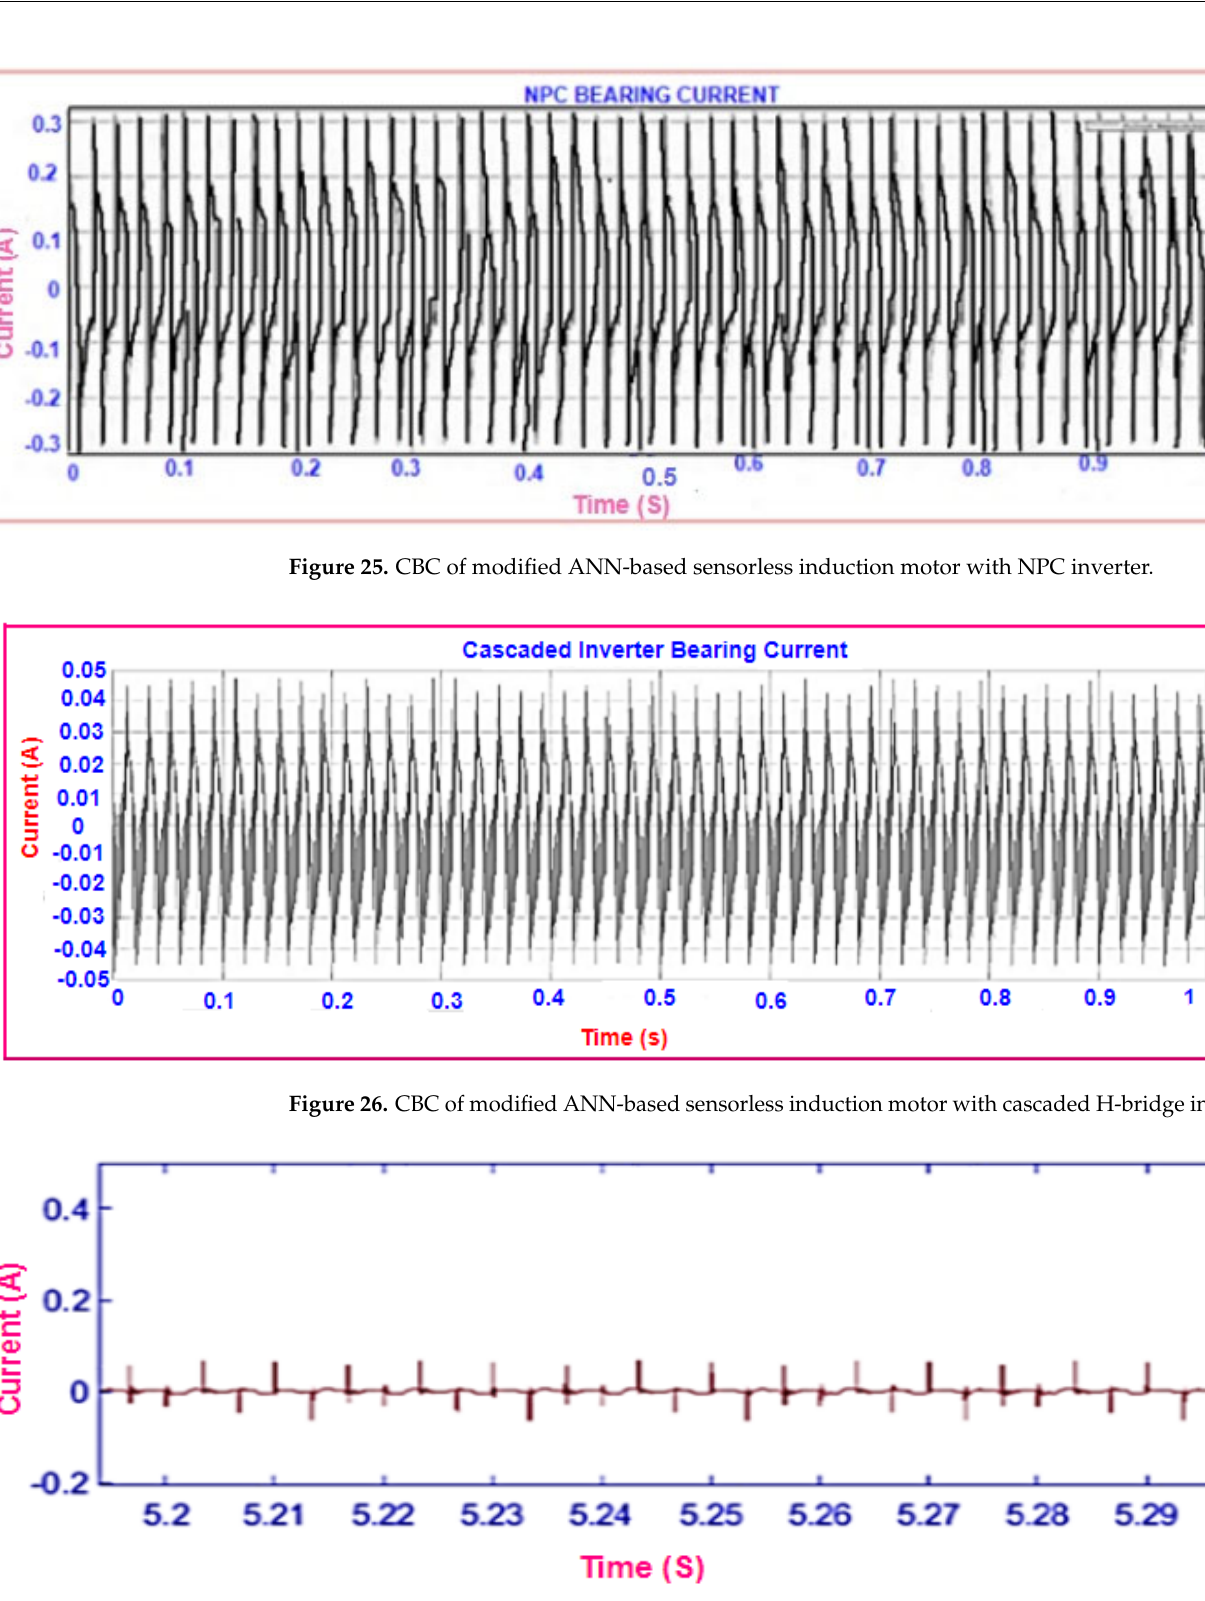
Figure 24. CBC of modified ANN ‐ based sensorless induction motor with T ‐ bridge inverter.